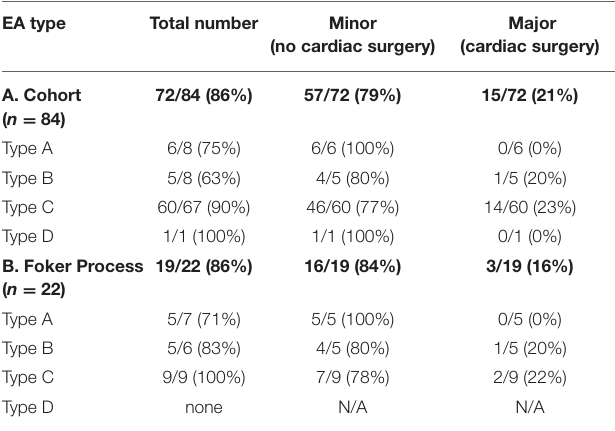
TABLE 2 | Incidence of co-existing congenital cardiac